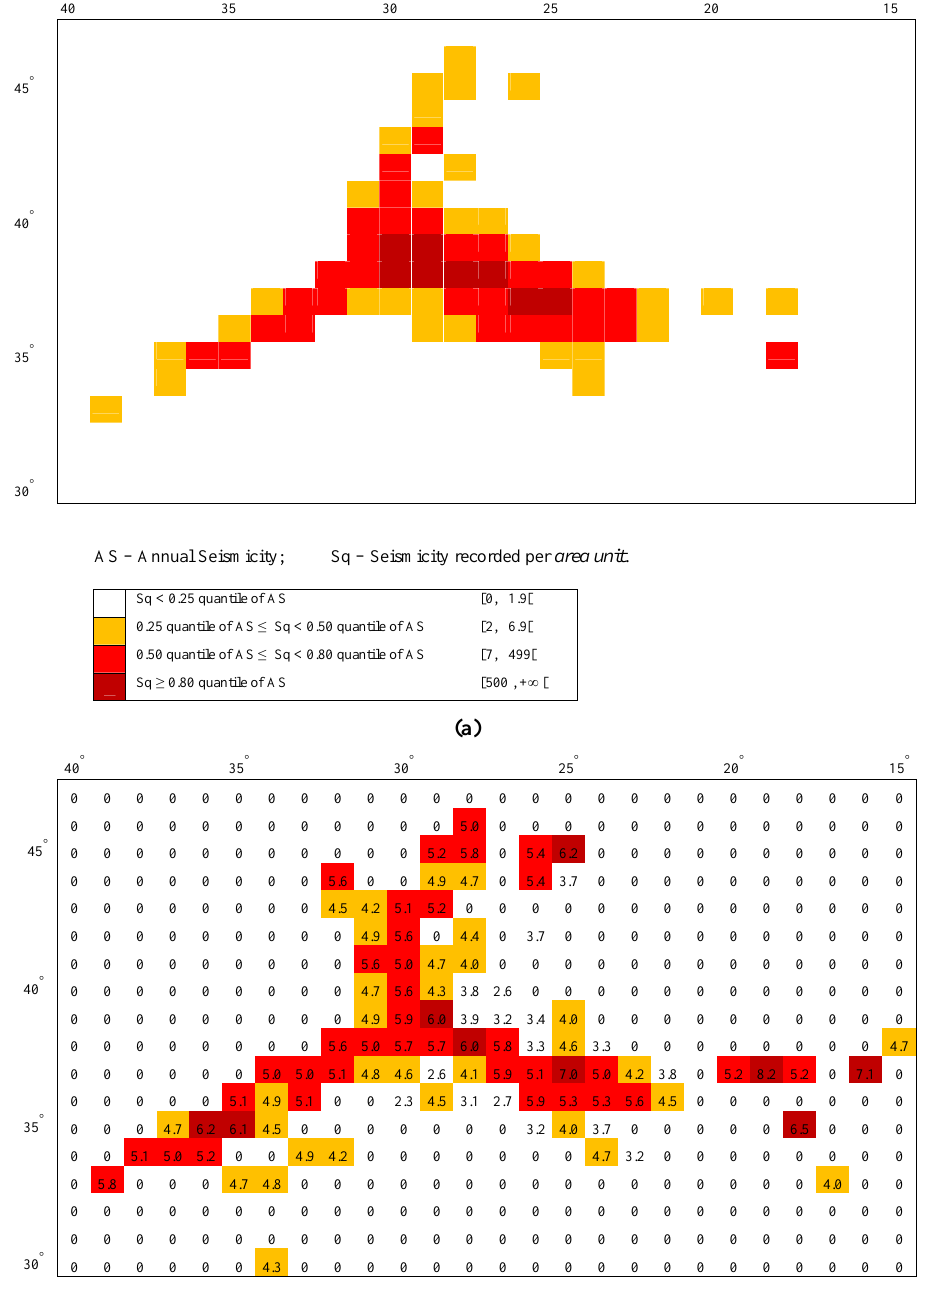
Replace Figure 8b by the following (The cell 49N, 25W was not in orange color.)